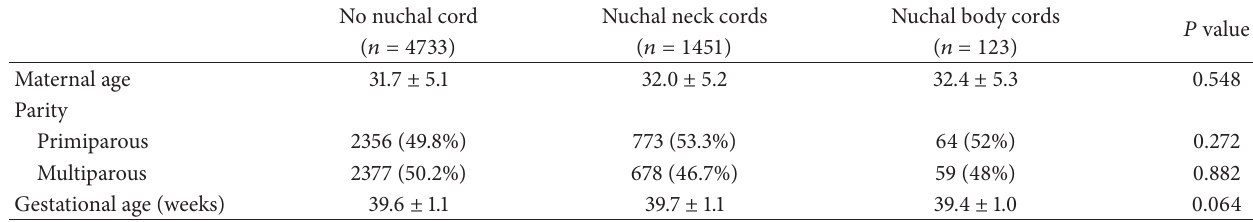
Table 1: Maternal characteristics, compared between the 3